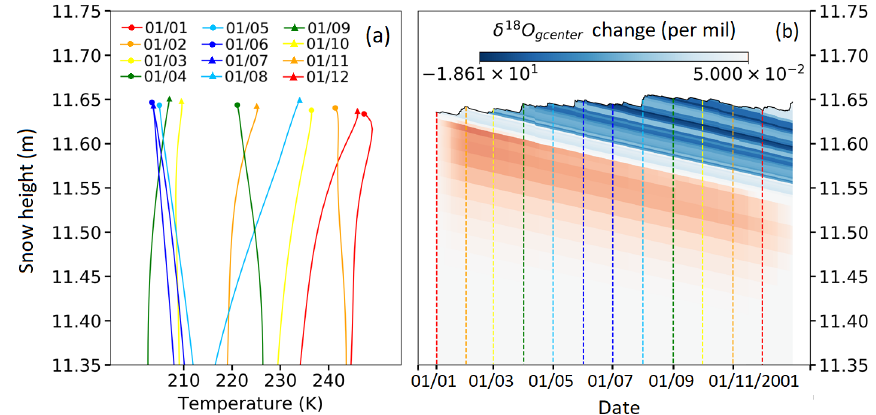
Figure 7. Simulation 5: cumulative change in δ 18 O values at the grain center (relative to t 0 ) over 6 months. Simulation with snowfall with varying δ 18 O (function of T air ) , vapor transport active, wind, and weight compaction